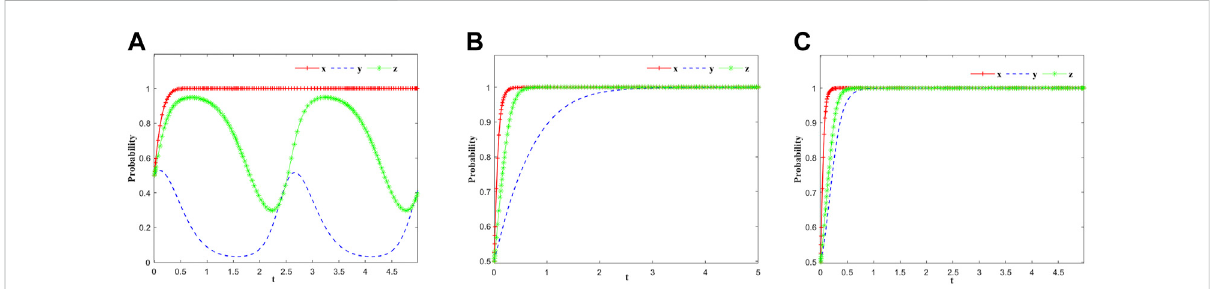
FIGURE 4 Simulation of the evolutionary strategy of the three parties under different levels of supervision by the central government. Note: t denotes the time, i.e., the speed of achieving low carbon treatment, and γ = 0.2, 0.5, 0.8 in Panel 4 (A – C) , respectively, denote that the central government ’ s regulation of local governments ranges from small to